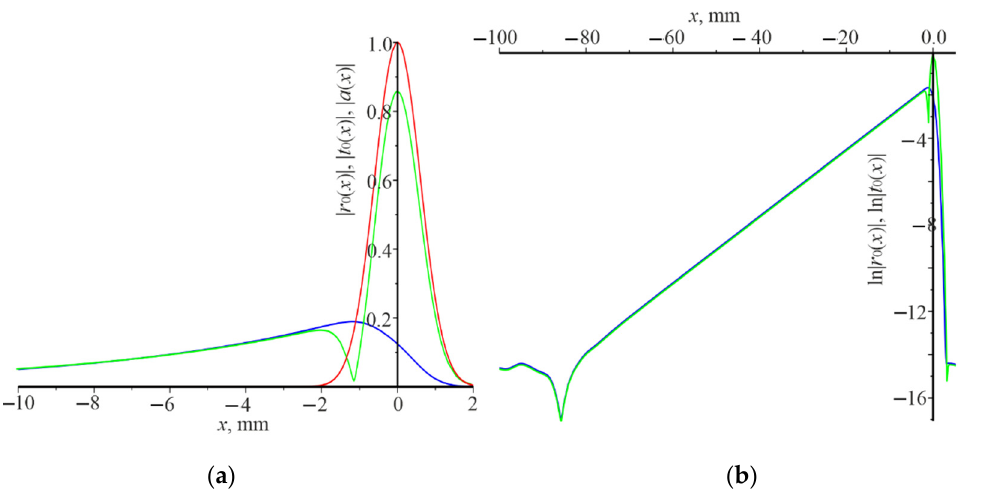
Figure 7. The distribution of the field amplitude along the x coordinate of the incident Gaussian beam | a ( x )| (red curve), reflected beam | r 0 ( x )| (blue curve), the transmitted beam | t 0 ( x )| (green curve) ( a ); ln| r 0 ( x )| (blue curve), ln| t 0 ( x )| (green curve) ( b ). Numerical calculations were carried out under the conditions d = 0.78 µ m, λ = 1.23 µ m, θ = π /18, L = 1.5